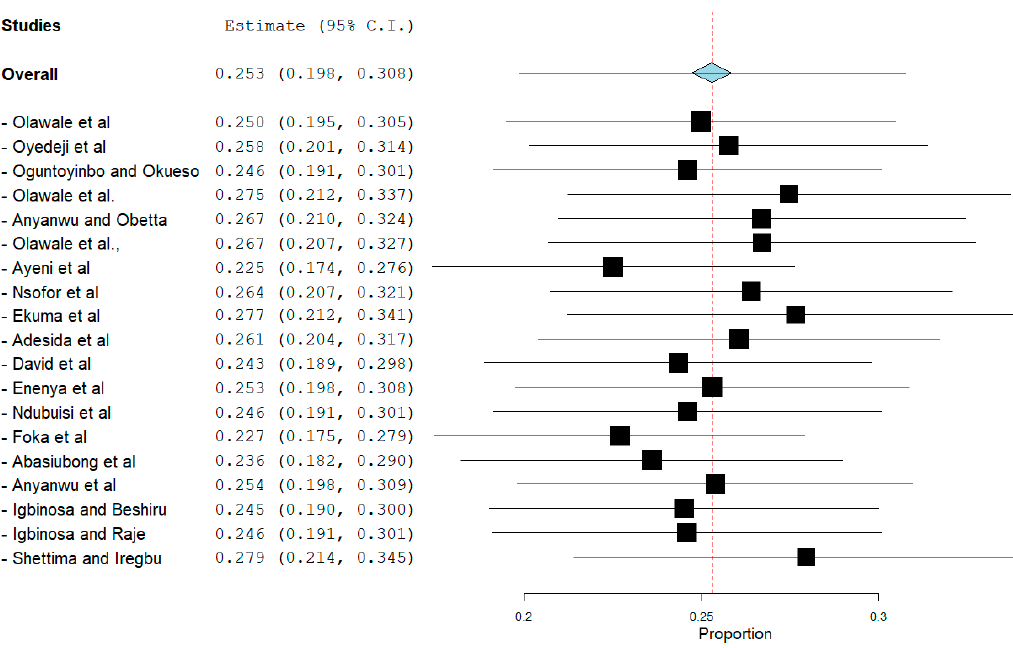
Figure 4. Leave-one-out forest plot of VRE in Nigeria.